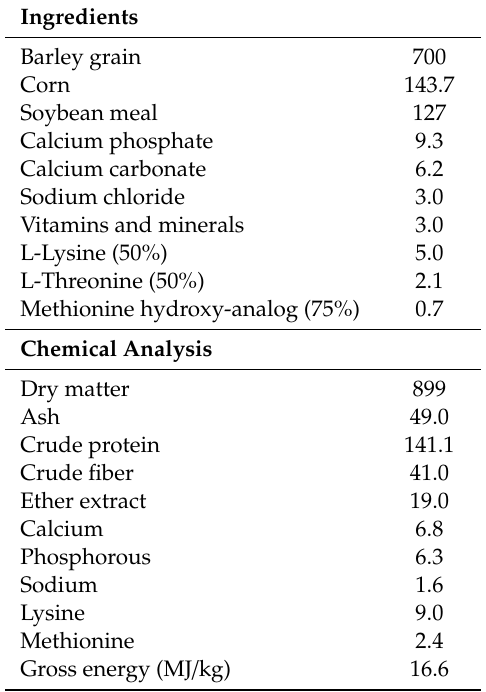
Table 1. Composition and chemical analysis (g / kg) of the experimental